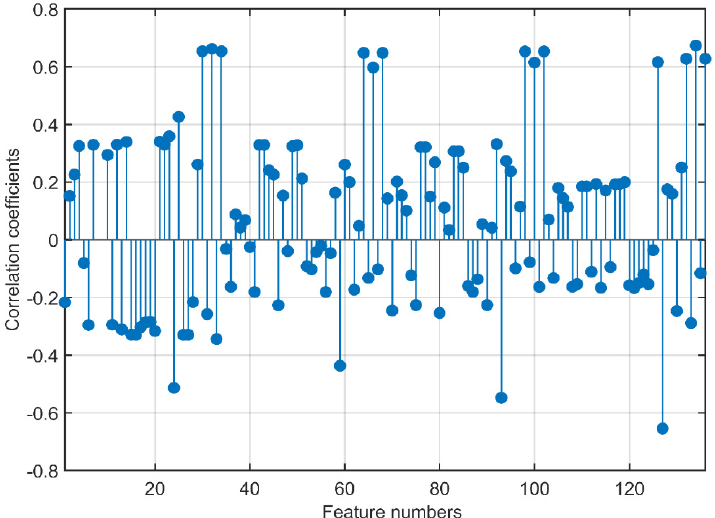
Figure 12. Correlation coefficients show the relationship of the features with the target variable .